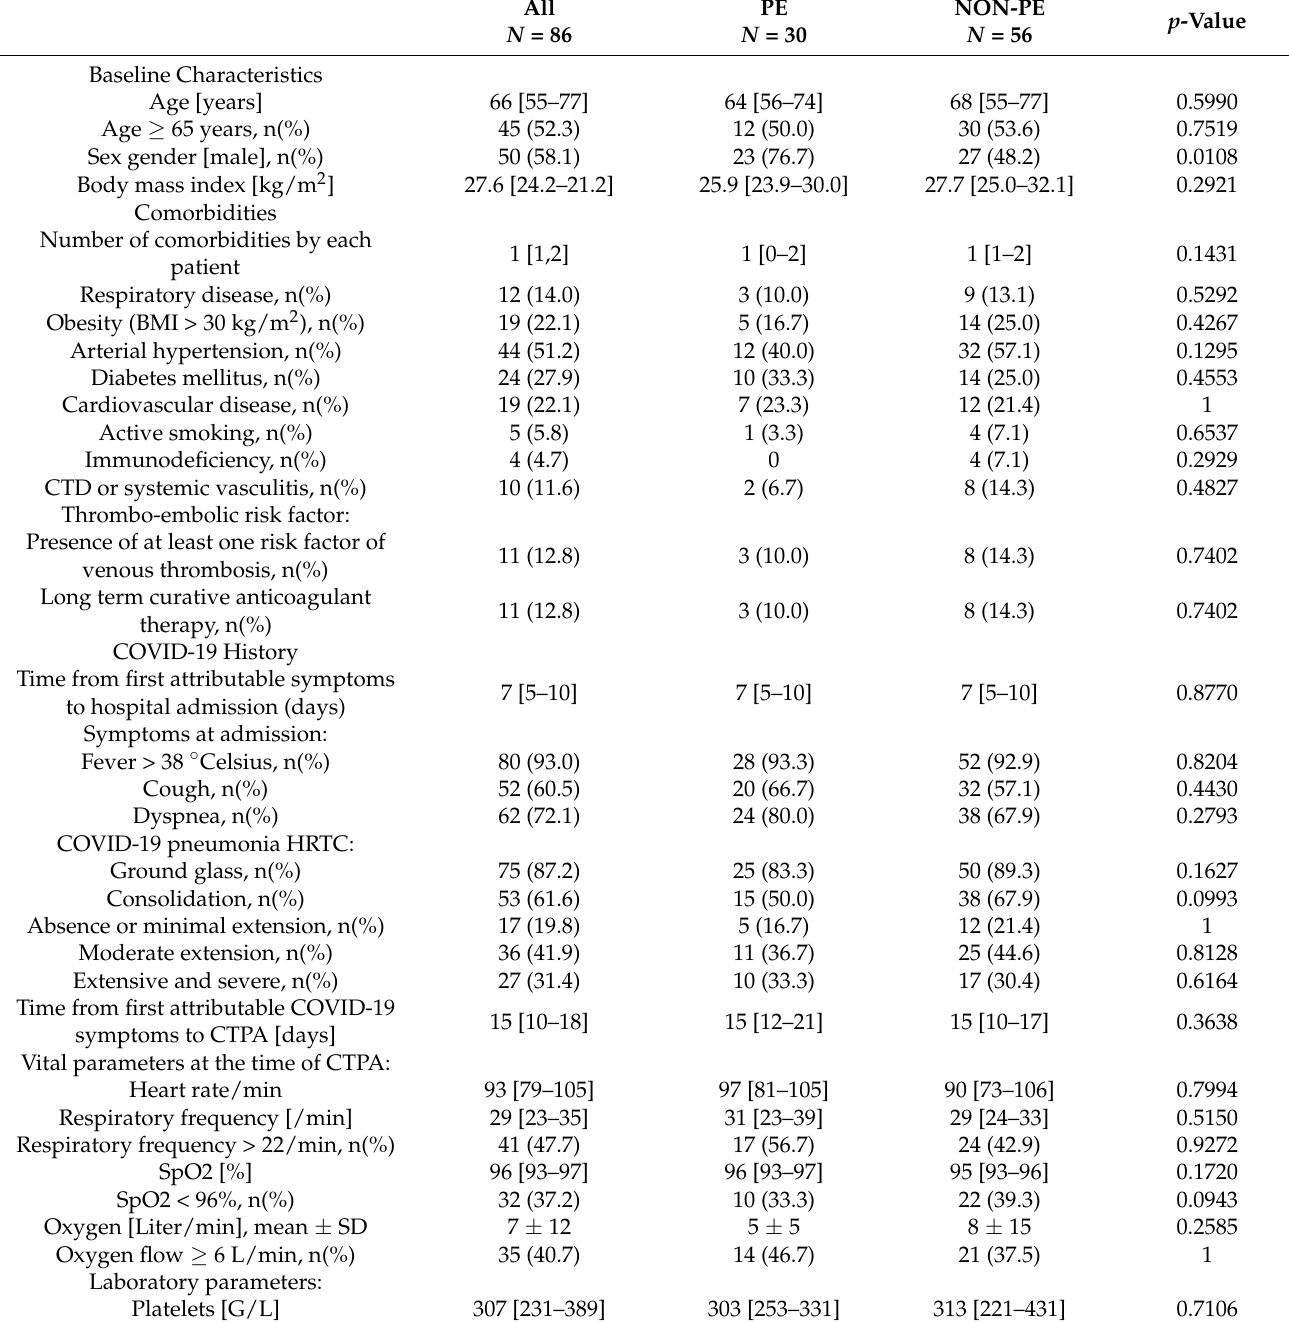
Table 1. Baseline characteristics of population at the Pulmonary Embolism